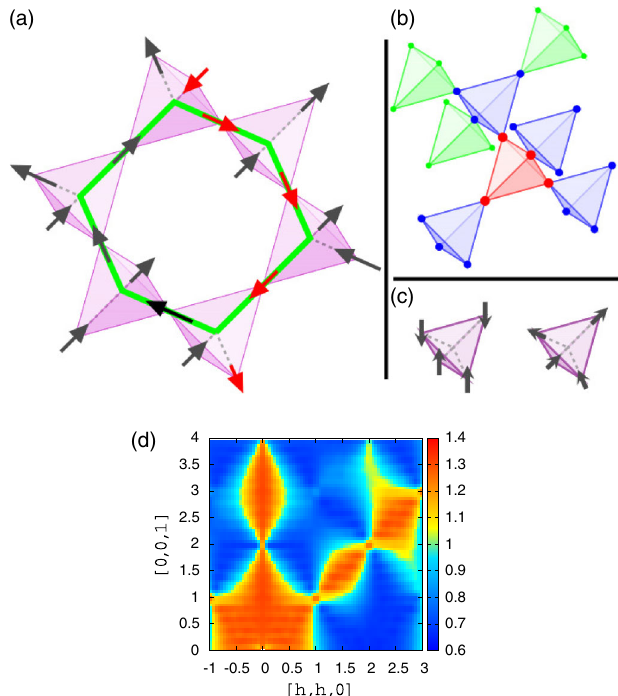
FIG. 1. (a) A portion of the pyrochlore lattice, made of corner- sharing tetrahedra. All spins respect the ice rules (two in, two out). The red spins form a string propagating along the (cid:1) ^ z axis, while the green hexagon represents a nonwinding loop of six spins. (b) The Husimi-cactus construction for the pyrochlore lattice. (c) Mapping between spins with easy-axis anisotropy respecting the symmetry constraints of the lattice (right), and the corresponding pseudospins (left). (d) Scattering function S ð Q ; T Þ of the NNSI model at T ¼ 1 K for a system of 4000 spins, ¼ 1 : 8 K . The pinch points are Ti O with J simulating Ho 2 2 7 eff evident at [0,0,2], [1,1,1], and